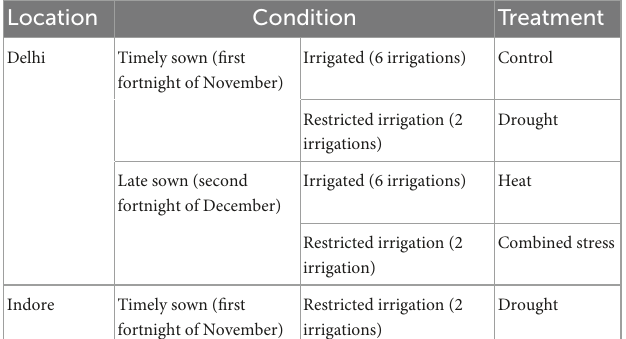
TABLE 1 Details of the experiment locations, sowing conditions of the mapping